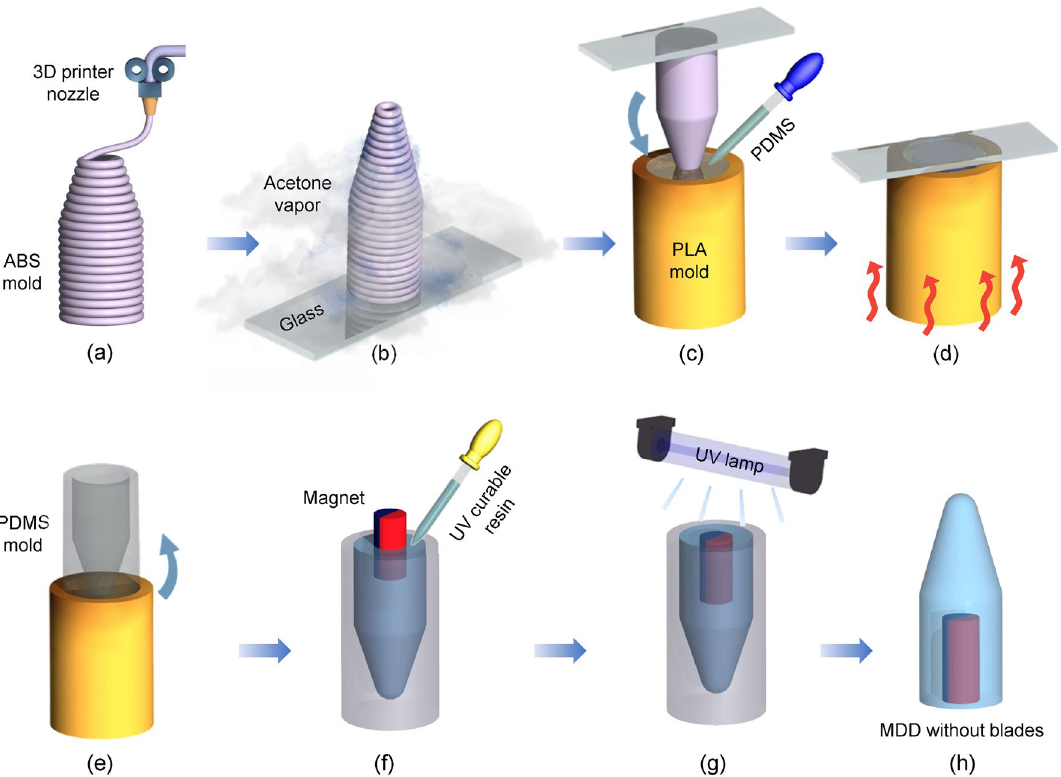
Figure 3. Manufacturing process for the plain-type MDD without blades. ( a ) 3D printing the ABS casting mold with 0° blades using FFF-type 3D printer; ( b ) Polishing the rough mold surface using cold acetone vapor fumigation process, ( c ) Inserting the polished ABS mold into uncured PDMS mixture and degassing PDMS; ( d ) Curing the PDMS mixture; ( e ) Separating the PDMS mold; ( f ) Pouring the UV curable resin into the